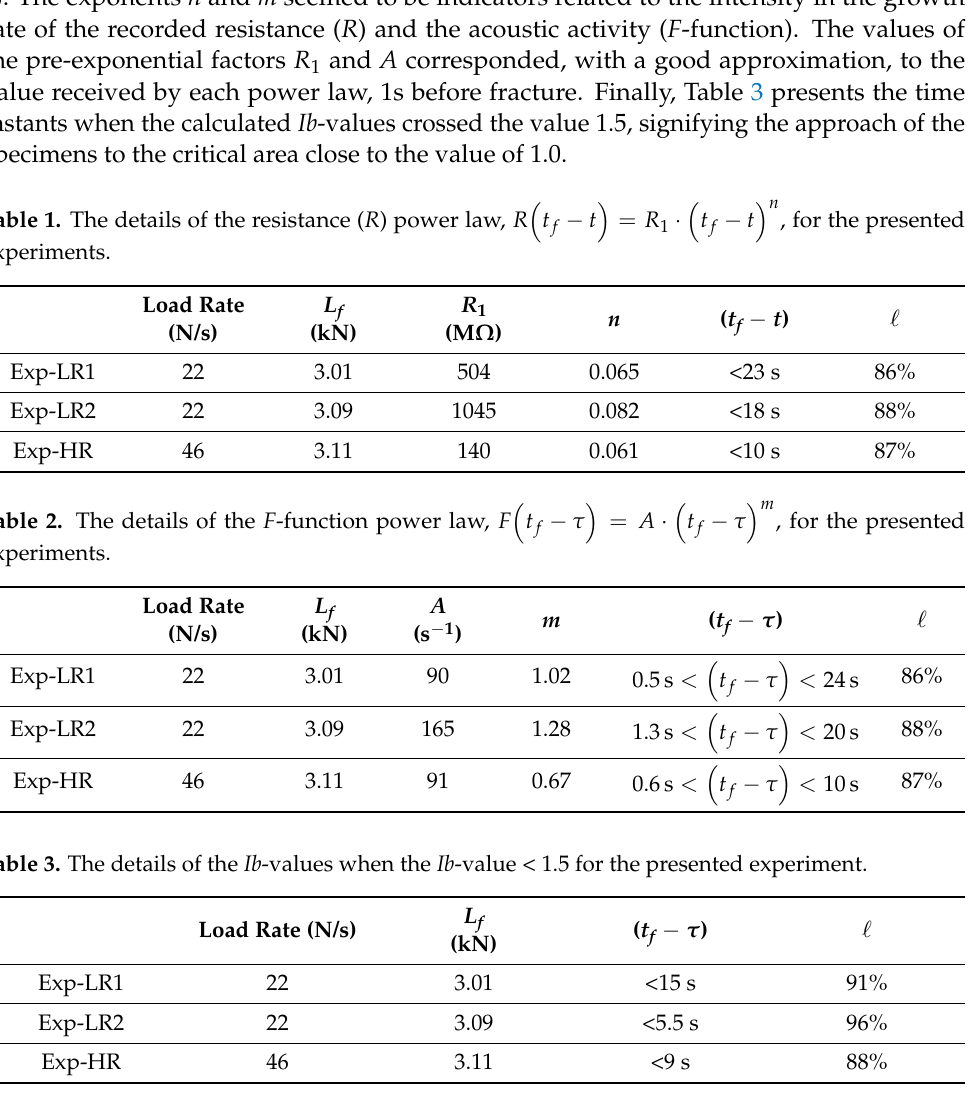
(cid:16) (cid:17) (cid:16) (cid:17) n = R · t f − t t f − t , for the presented 1